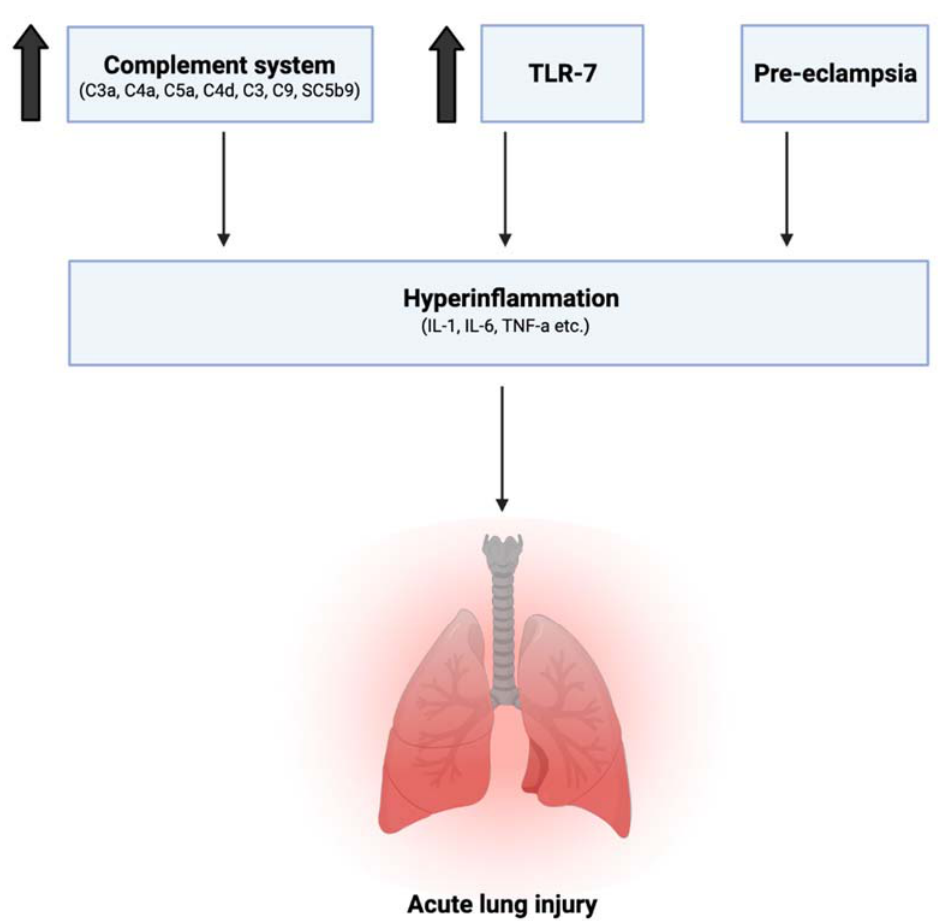
Figure 2. Immune changes in pregnant physiology that increase risk of hyperinflammation in SARS-CoV-2 infection: Increase in complement activation, toll-like receptors TLR-1 and TLR-7, as well as the preeclamptic state, has been linked to the release of pro-inflammatory factors and greater lung injury in SARS-CoV-2. This is on top of increased levels of IL-6, IL-12, IFN- α , and TNF- α already observed in normal pregnancy when compared to nonpregnant levels.